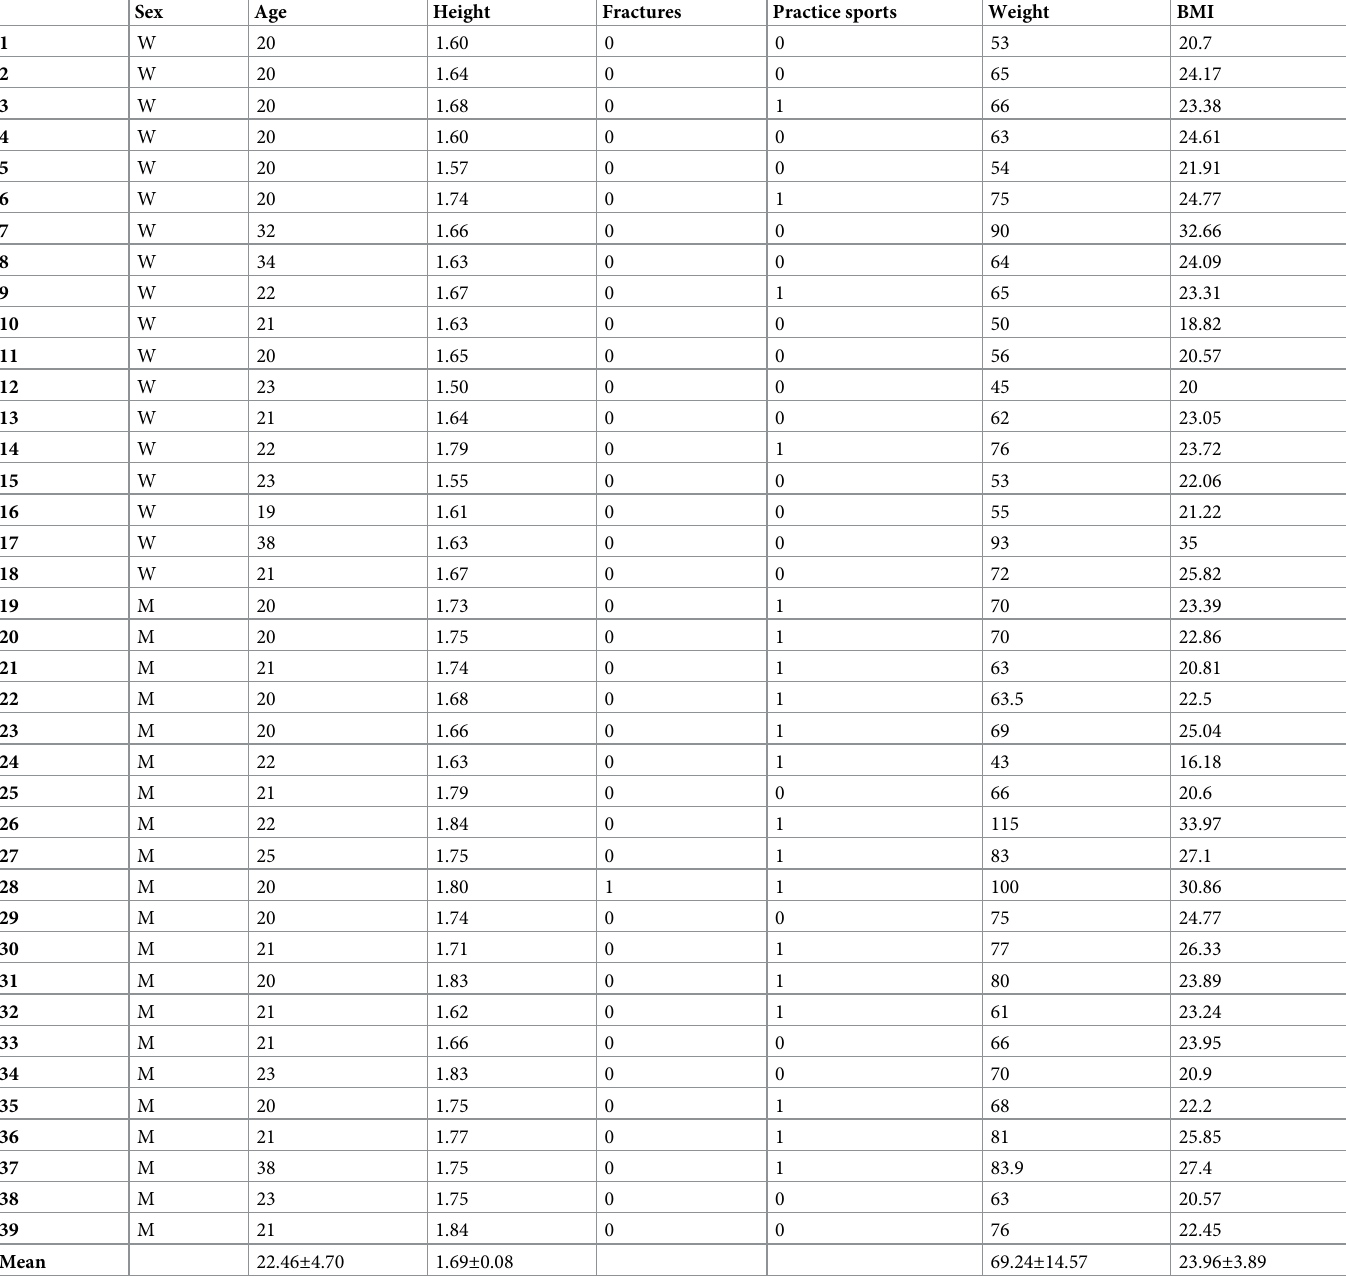
Table 1. Characterization of the